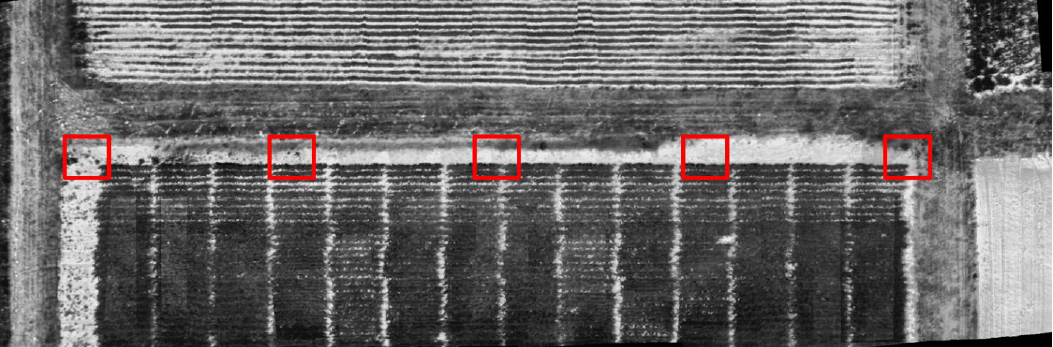
Figure 19. Orthophoto result from direct approach for FLIR thermal July 25th data collection (red boxes show the location of the check points, Orignal Image GSD ≈ 0.03 m ).